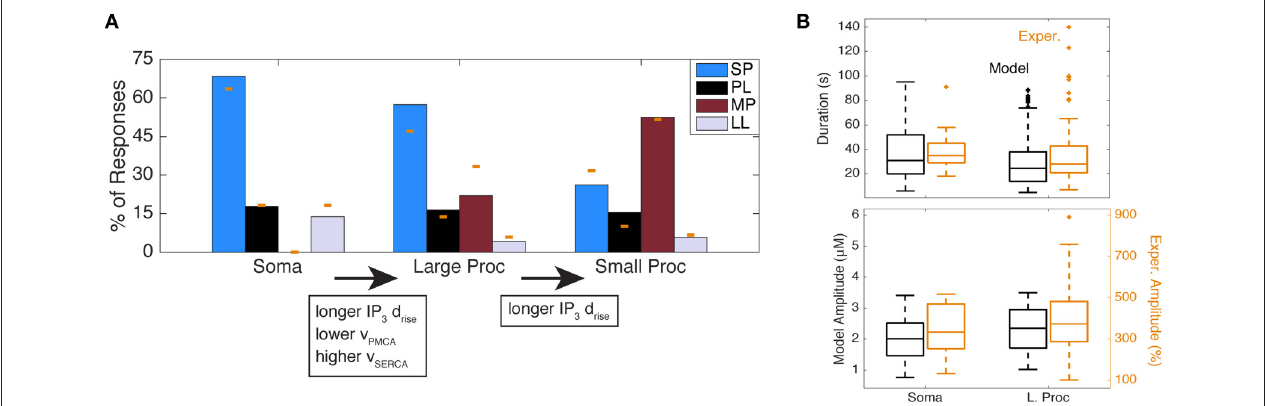
FIGURE 7 | Simulation of response type distributions matching experimental distributions of astrocyte subcompartments. (A) Response type distributions in the model with parameters adjusted to the soma, large processes, and small processes. The yellow bars indicate the experimental data from Figure 2D . (B) Ca 2 + durations and amplitudes of all response types in the model (from (A) ; in black) and experiments (from Figure 2D ; in yellow) in the soma and large processes. One outlier was excluded from the experimental soma duration plot, with a duration of 363s (same outlier omitted from Figure 4B